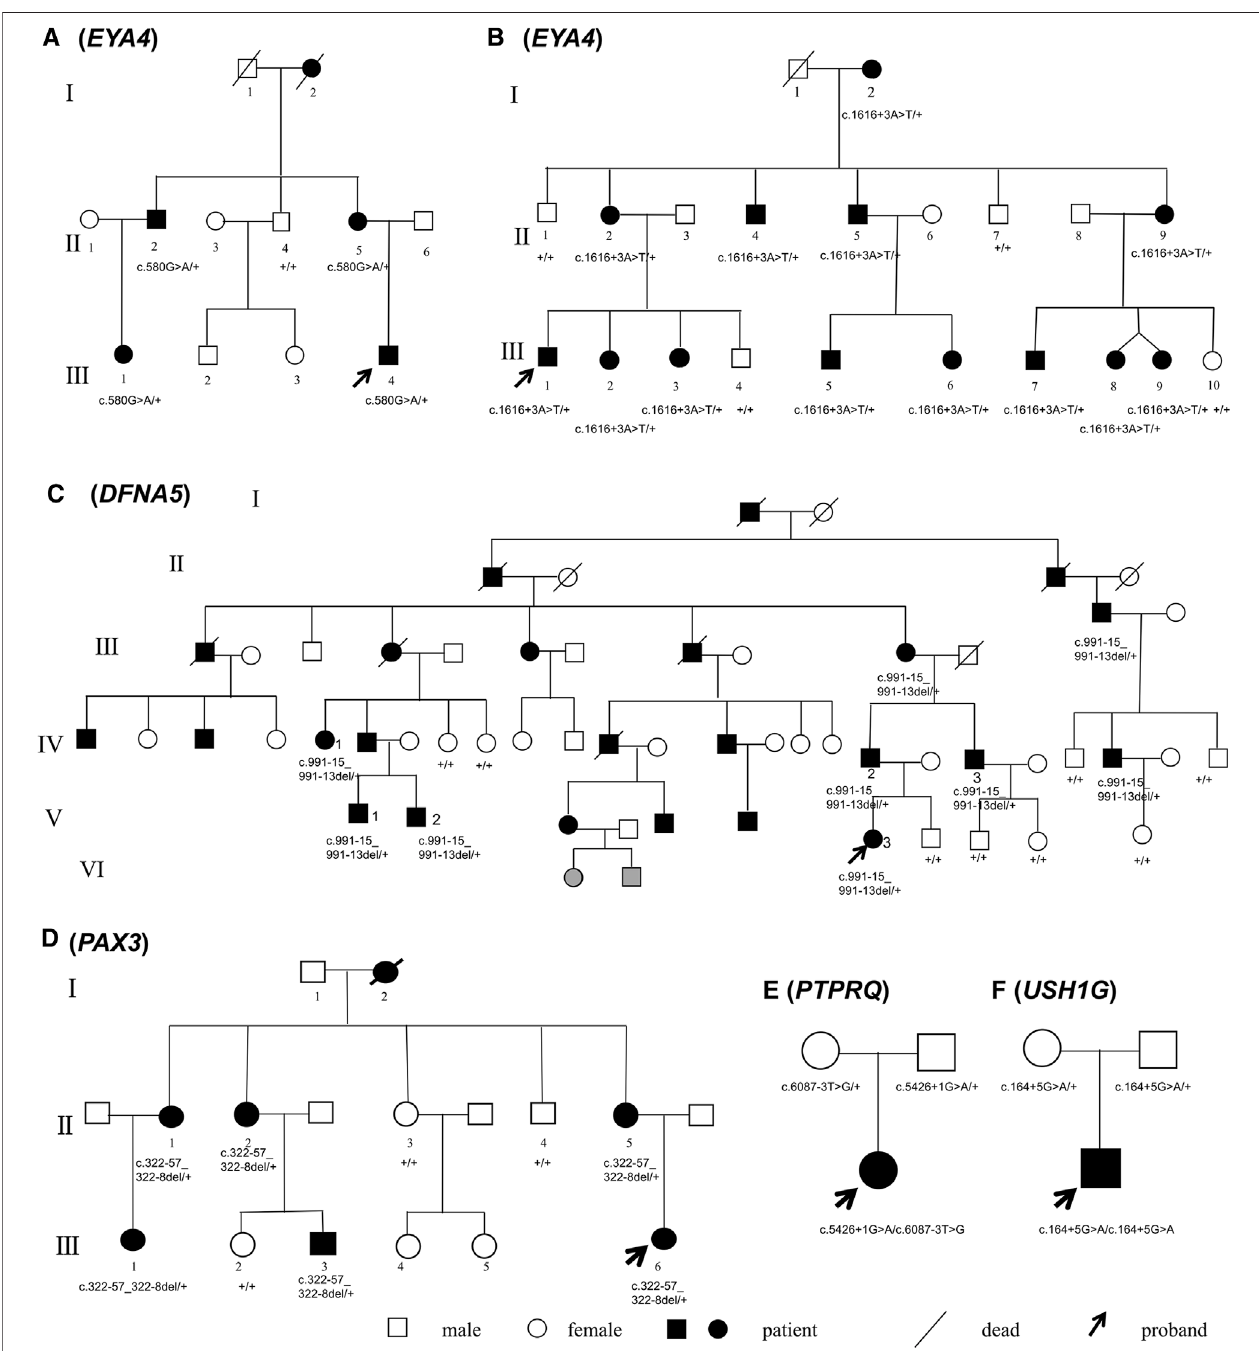
FIGURE 1 | Pedigrees of Families (A – F) . Mutations of the causative genes (in parentheses) are marked under the corresponding individuals. Symbols in gray indicate phenotype too young to be determined.